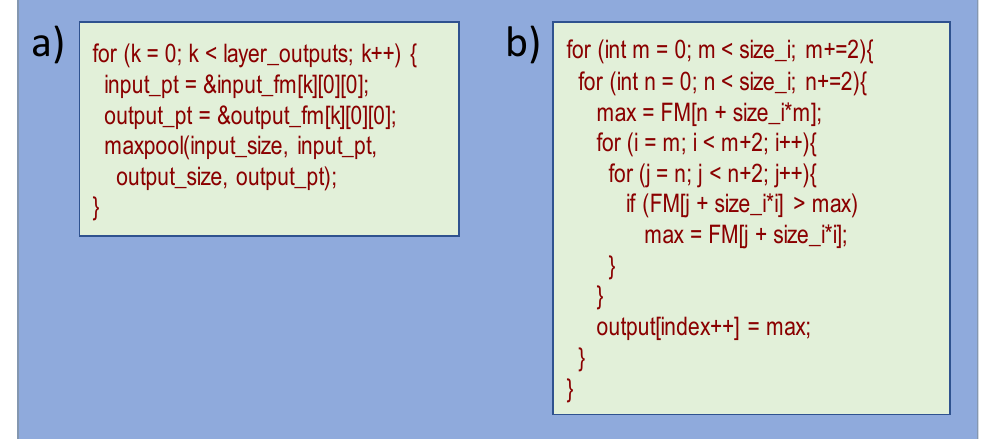
Figure 8. ( a ) Maxpool layer in generic C code; ( b ) Maxpool function inner operations (Layers: 3, 6, 10, 14, 18).